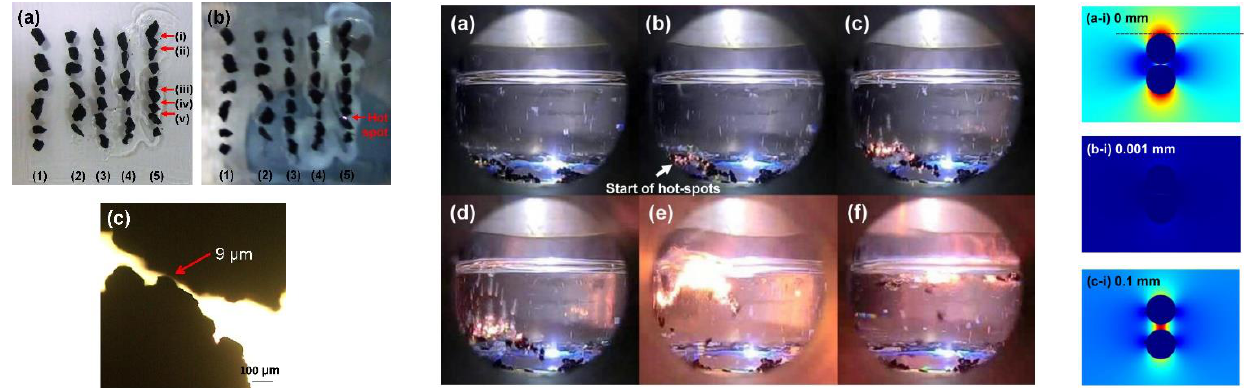
Figure 1. hot spots generated in activated carbon particles fixed at various intervals on a glass plate: (a) the initial sample; (b) formation of hot spots between the activated carbon particles under microwave irradiation; (c) observed distance between the particles in column (4) with an optical microscope (left). High-speed camera photograph of the electrical arc discharge occurring on the activated carbon in toluene solvent under the microwaves’ E -field irradiation (center) where (a) shows bubbles on the activated carbon surface after 3s, (b) shows an orange-colored light from the aggregated activated carbon particles after 16 s at the lower left position, (c) shows greater number of bubbles formed around the emitted light, (d) shows the intense luminescence on the activated carbon surface, (e) shows the light from the hot spots reaching maximum intensity, (f) shows the redispersion of aggregated activated carbon particles and disappearance of luminescence from the activated carbon surface. Distribution of the microwaves’ E-fields (2.45 GHz) around two activated carbon particles in toluene solvent simulated with the COMSOL Multiphysics software version 4.3a. Colored images (a – i), (b – i) and (c – i) display the E-field intensity in two activated carbon particles in toluene together with the magnitude of the gap between the particles, whereas a-ii, b-ii and c-ii graphics show the magnitude of the E field (V m −1 ) within this gap (right). Reproduced with permission from [38], Copyright Elsevier, 2013.